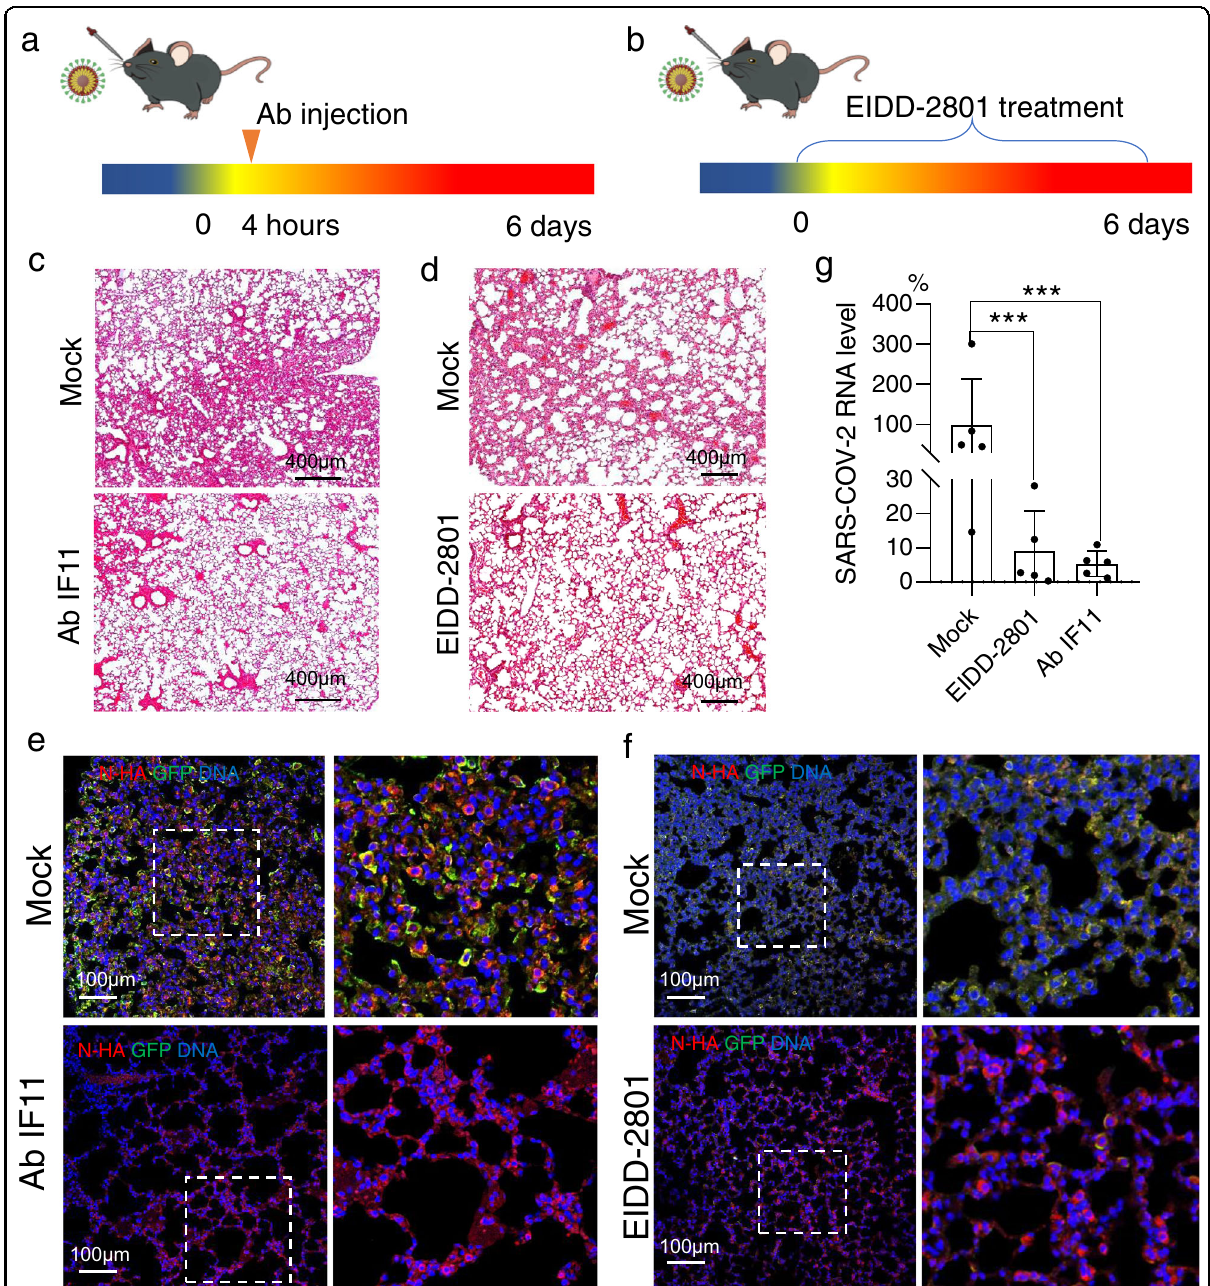
Fig. 5 Therapeutic antibodies and antiviral drugs restrict viral infection in Sftpc-hACE2-N F/F mice. a , b Sftpc-hACE2-N F/F mice were intranasally infected with 1 × 10 5 TCID 50 virus and euthanized to collect tissue samples at 6 dpi. a Equivalent numbers of 10-week-old male and female sftpc- hACE2-N F/F mice were administered vehicle or antibodies (Ab1F11) beginning at + 4 h by intraperitoneal injection ( n = 10 per group). Mice were intranasally infected with 1 × 10 5 TCID 50 SARS-CoV-2 GFP/ Δ N strain. b Animals were orally administered 1 μ g/kg EIDD2801 or vehicle before infection. Animals were euthanized at 6 dpi and lungs collected. c H&E staining shows the lung tissues of PBS or Ab1F11-treated mice. d H&E staining shows the lung tissues of vehicle and 1 μ g/kg EIDD 2801-treated mice. e Immuno fl uorescence staining shows mouse lungs from vehicle and Ab1F11-treated mice. f Immuno fl uorescence staining shows mouse lungs from vehicle and 1 μ g/kg EIDD 2801-treated mice. SARS-CoV-2 GFP/ Δ N GFP protein (green), and DAPI (blue). g Viral RNA was quanti fi ed by qPCR of mouse lung tissues from EIDD 2801-treated or Ab1F11-treated